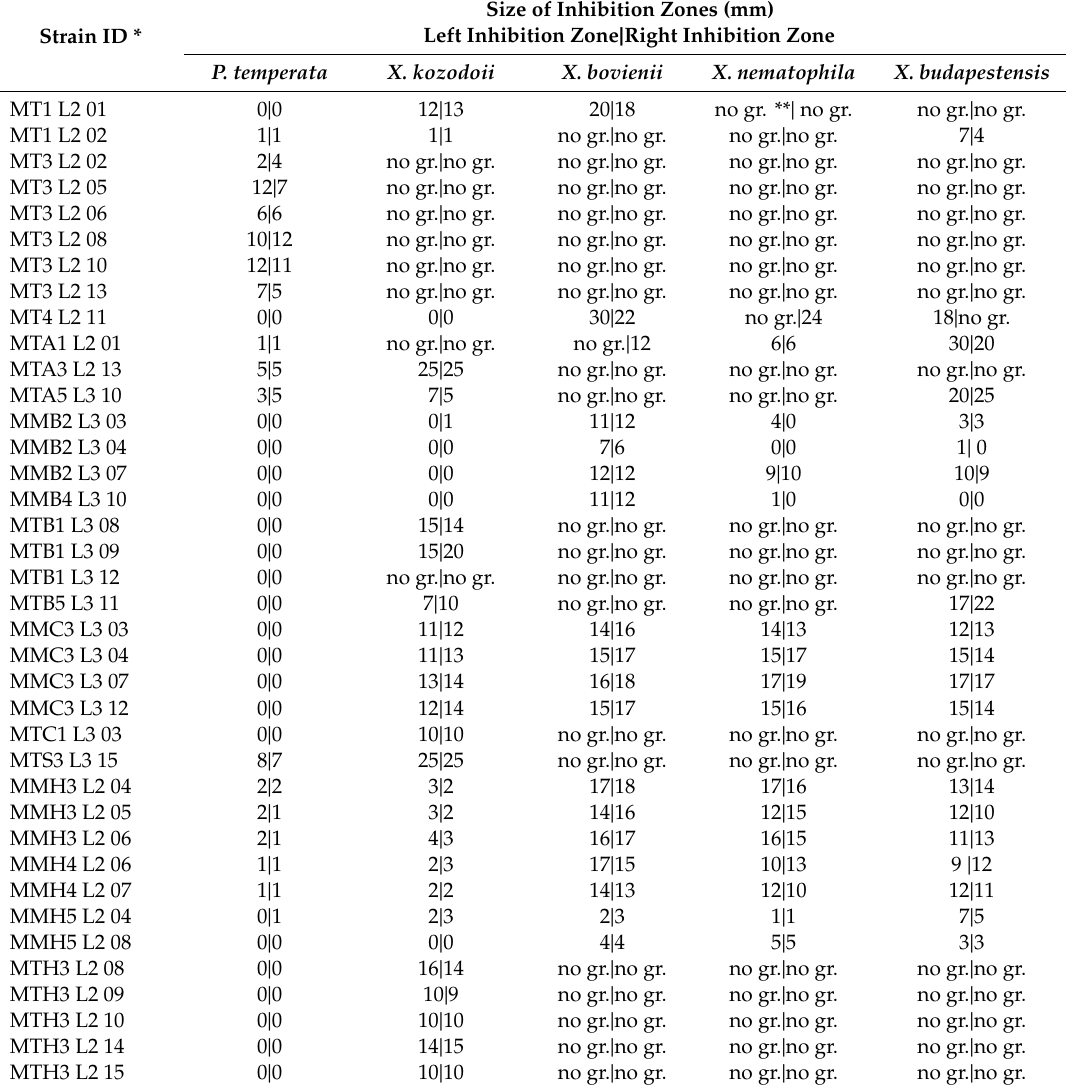
Table 1. Antagonistic activities of selected M. melolontha midgut isolates against five entomopathogenic bacteria (EPB) strains shown by cross-streak